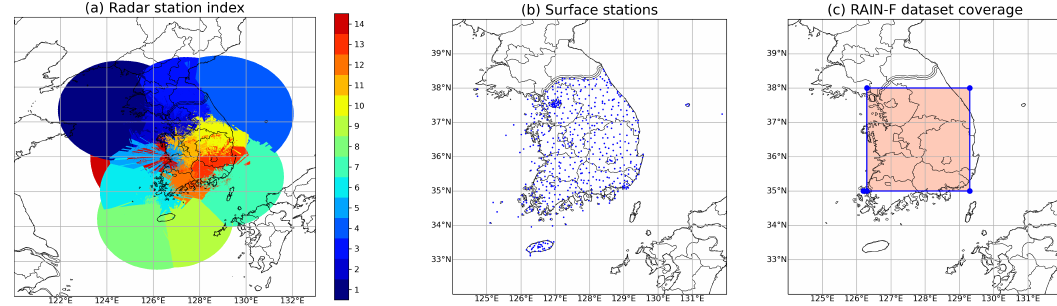
Figure 1. The observation station location and dataset coverage for ( a ) KMA radar network, ( b ) surface observations stations, and ( c ) the RAIN-F+